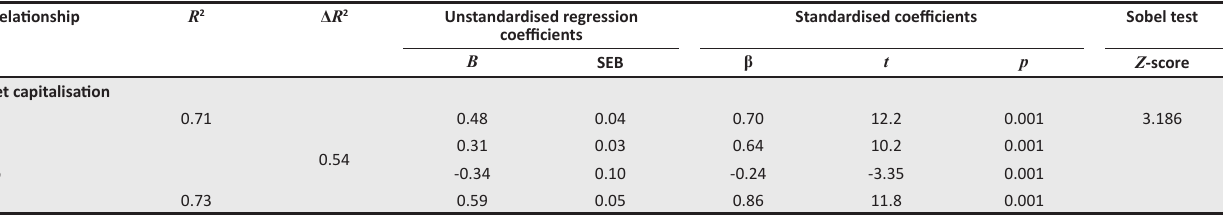
TABLE 7: Regression coefficients of mediation relationships between the intellectual capital dimensions and market capitalisation, controlling for human resource risk disclosure. Path relationship R 2 Δ R